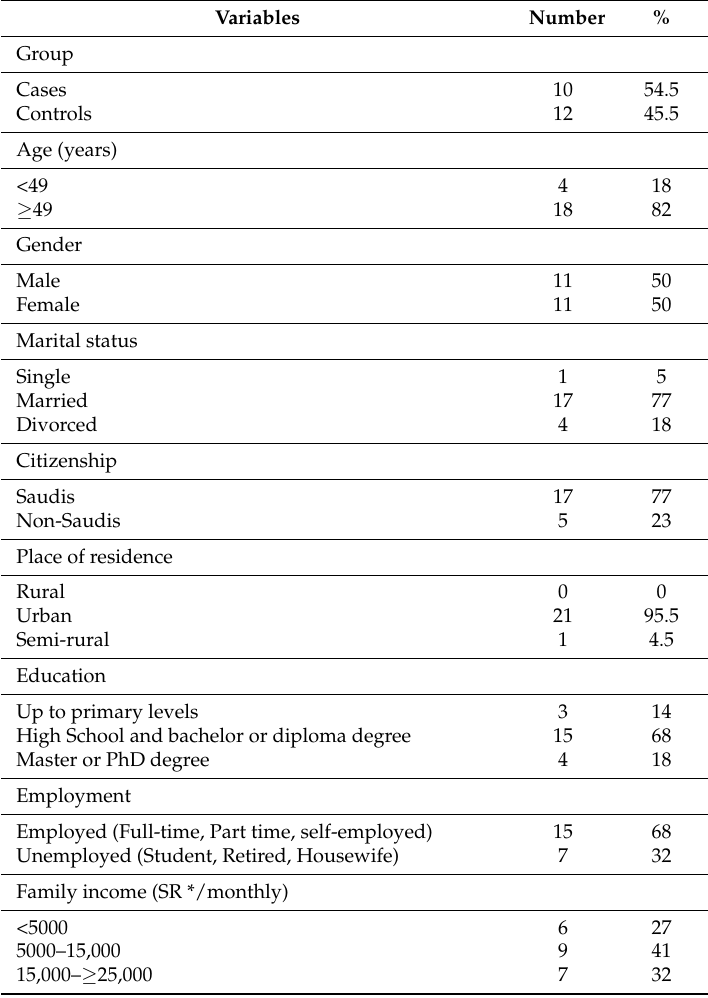
Table 1. Socio-demographic characteristics of study